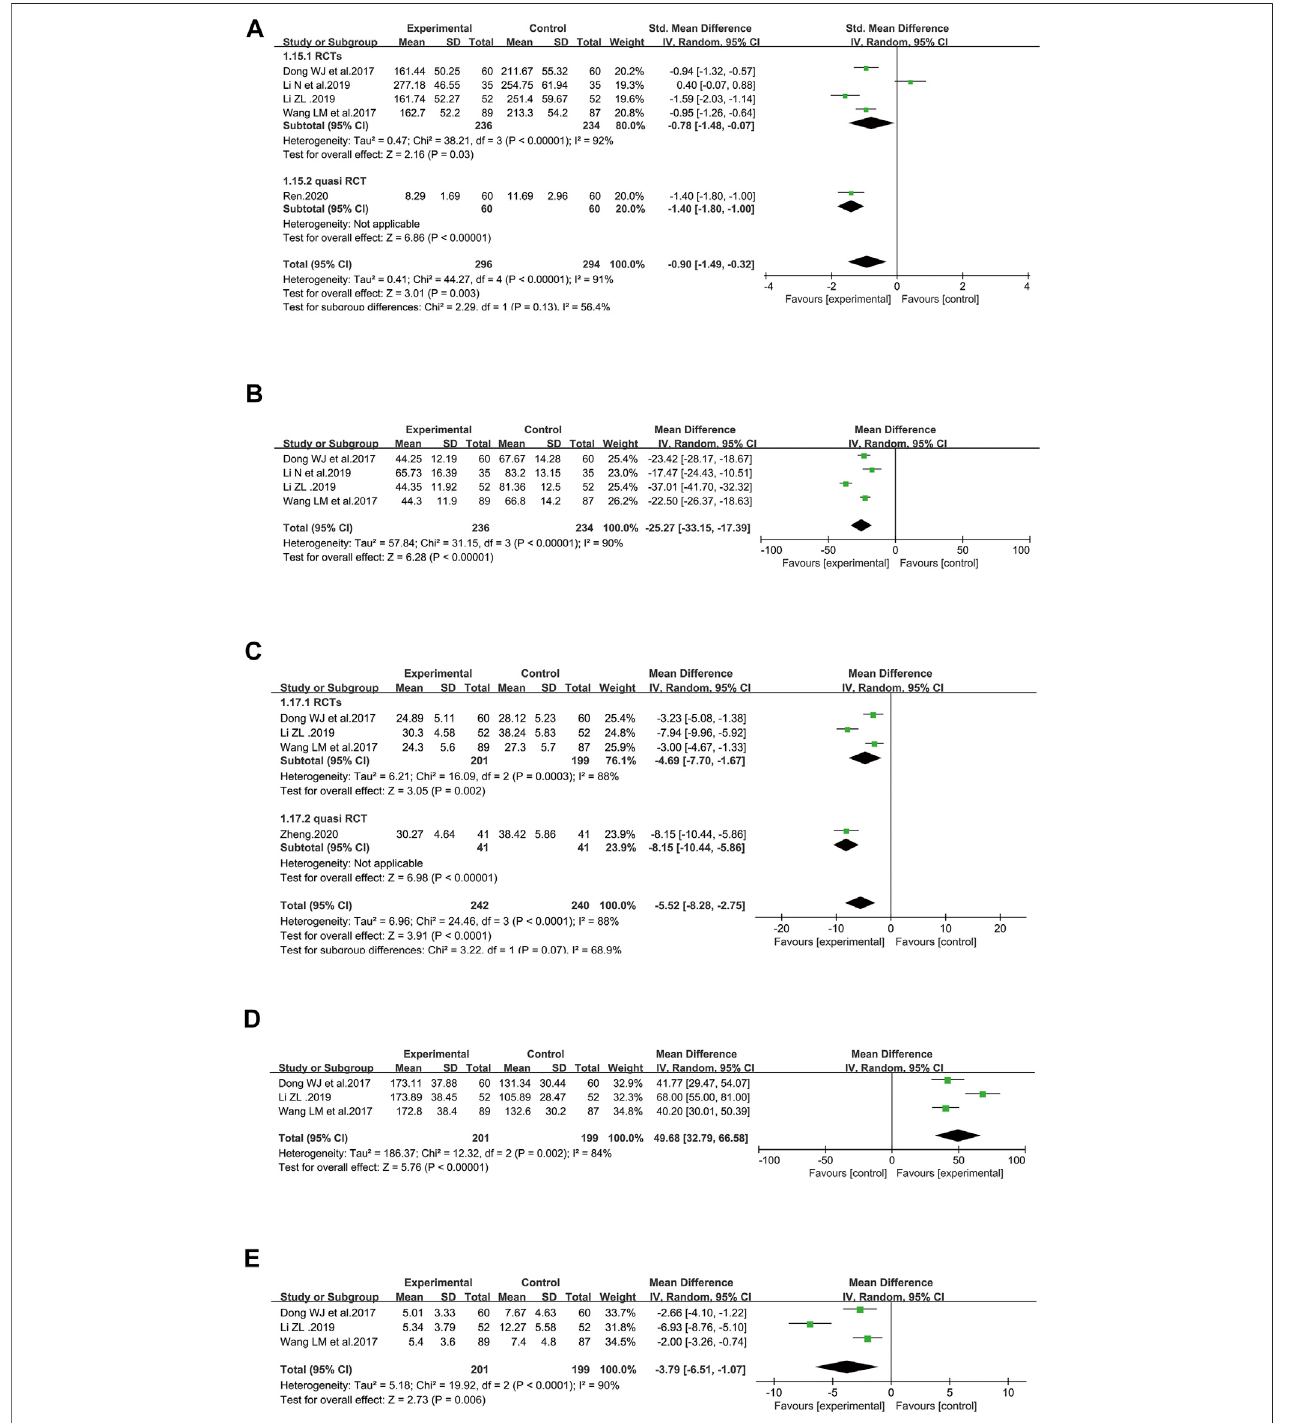
FIGURE7| Meta-analysisresultsofmarkersofendothelialperturbationandcoagulationdysfunctionbasedon: (A) sE-selectin; (B) vonWillebrandfactor; (C) APTT; (D) platelet counts; (E) D-Dimer.